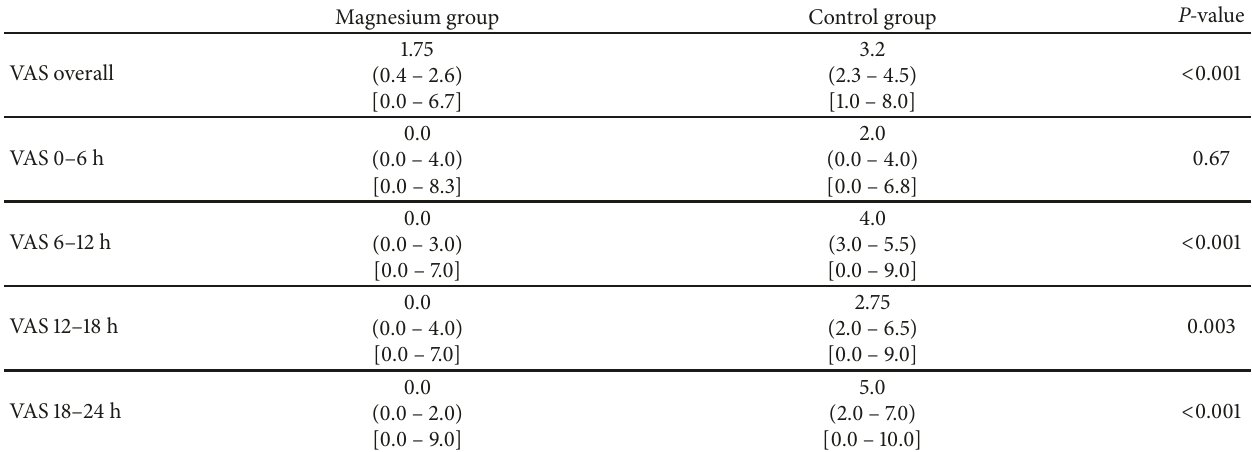
Table 4: Average VAS pain scores in first 24 hours after caesarean delivery.